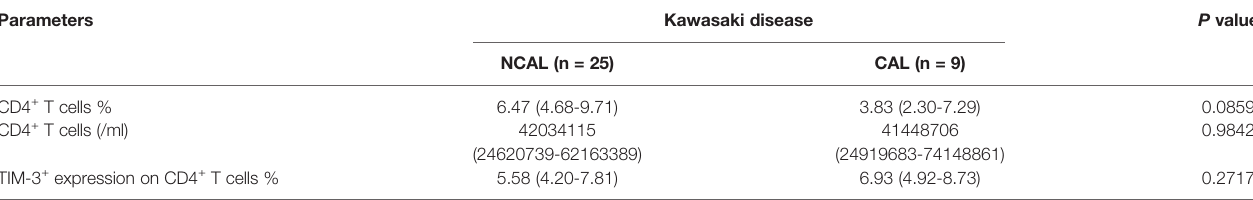
TABLE 5 | CD4 + T cells and TIM3 + CD4 + T cells between KD patients with and without CAL.